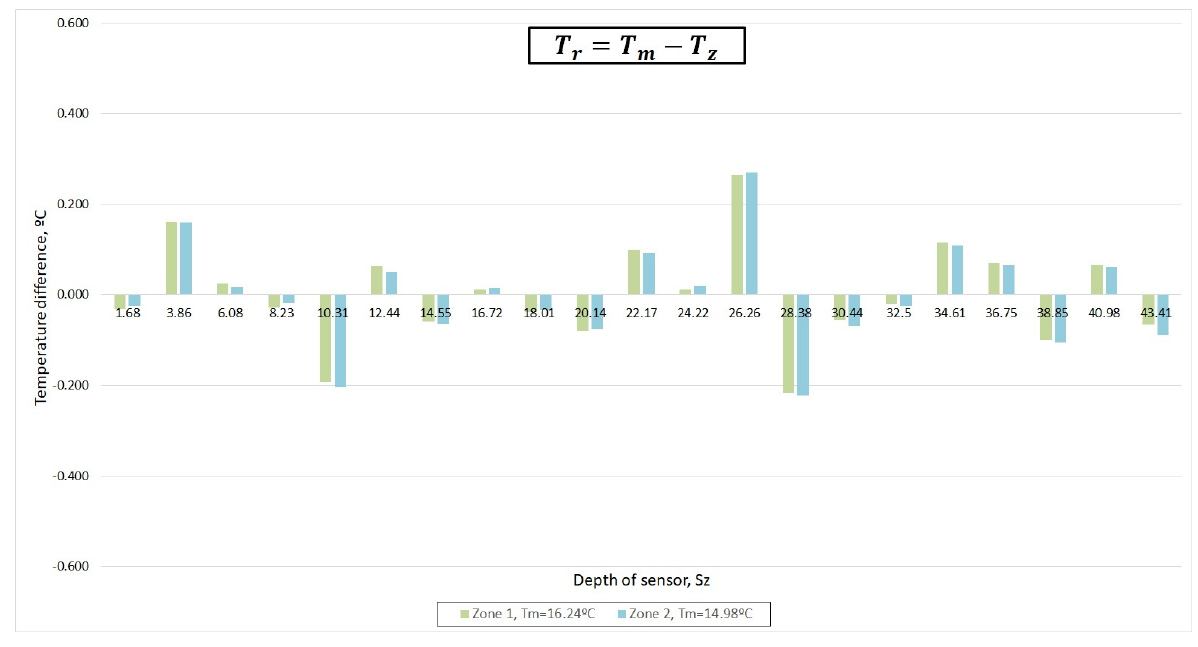
Figure 22. Measured temperature by different sensors characterized by not maintaining the deviation trend from the mean.